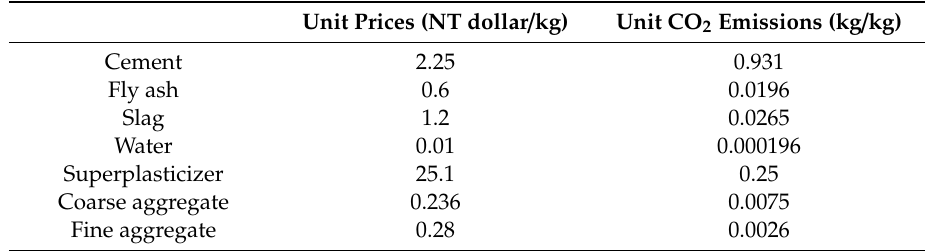
Table 1. The unit prices and CO 2 emissions of the concrete component